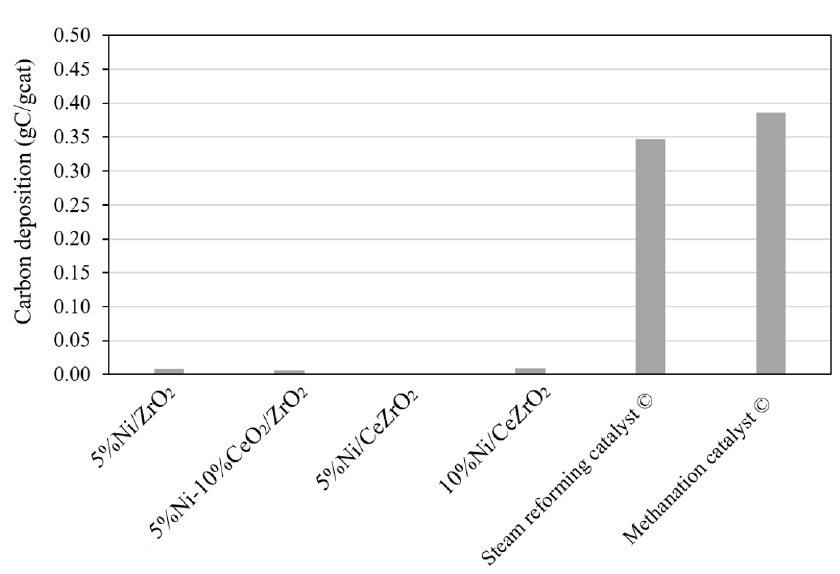
Figure 10. Carbon deposition of spent catalyst during activity and stability test.